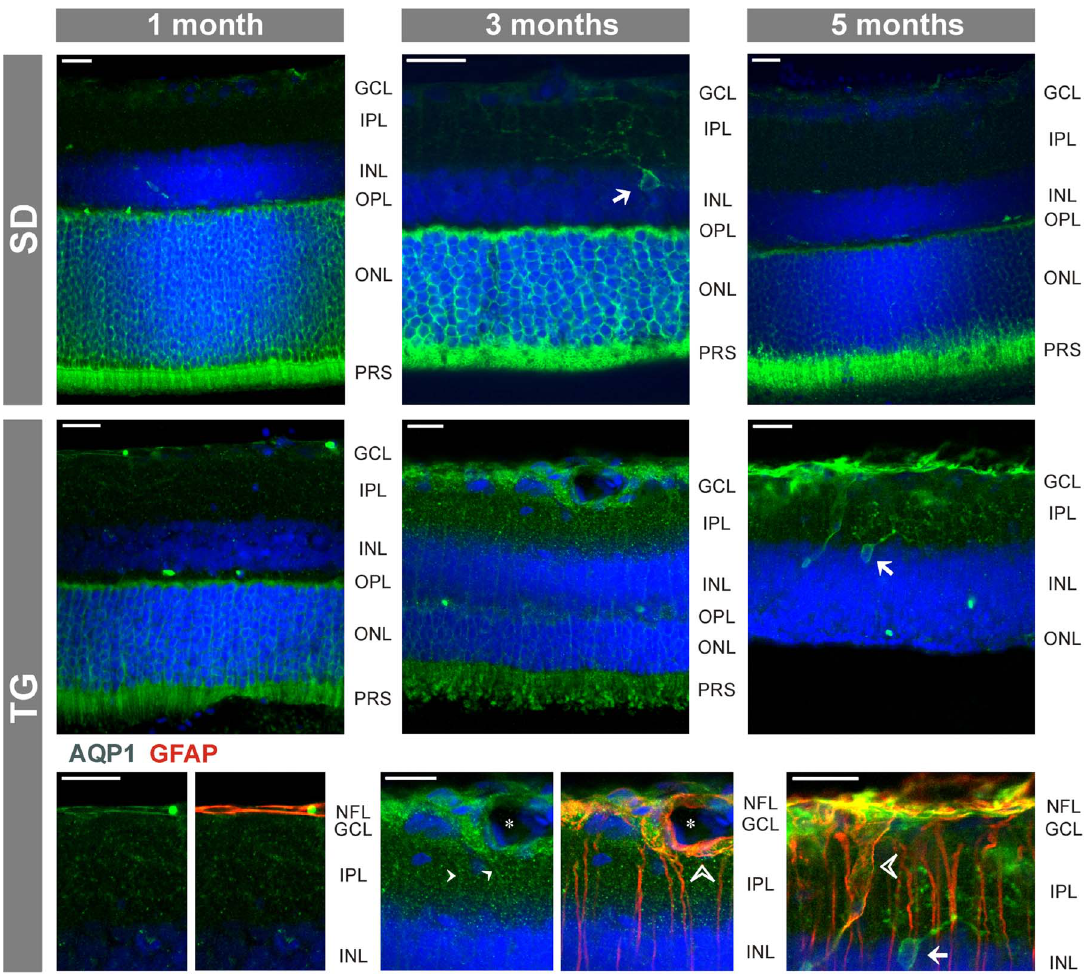
Figure 4. Retinal gene expression of GFAP, vimentin, nestin, Kir4.1, AQP1, and AQP4. The expression was determined in the neural retina of 3-months transgenic rats (n=4) compared to the gene expression in the retina of age-matched control rats (n=4). Significant difference vs . control: * P , 0.05.